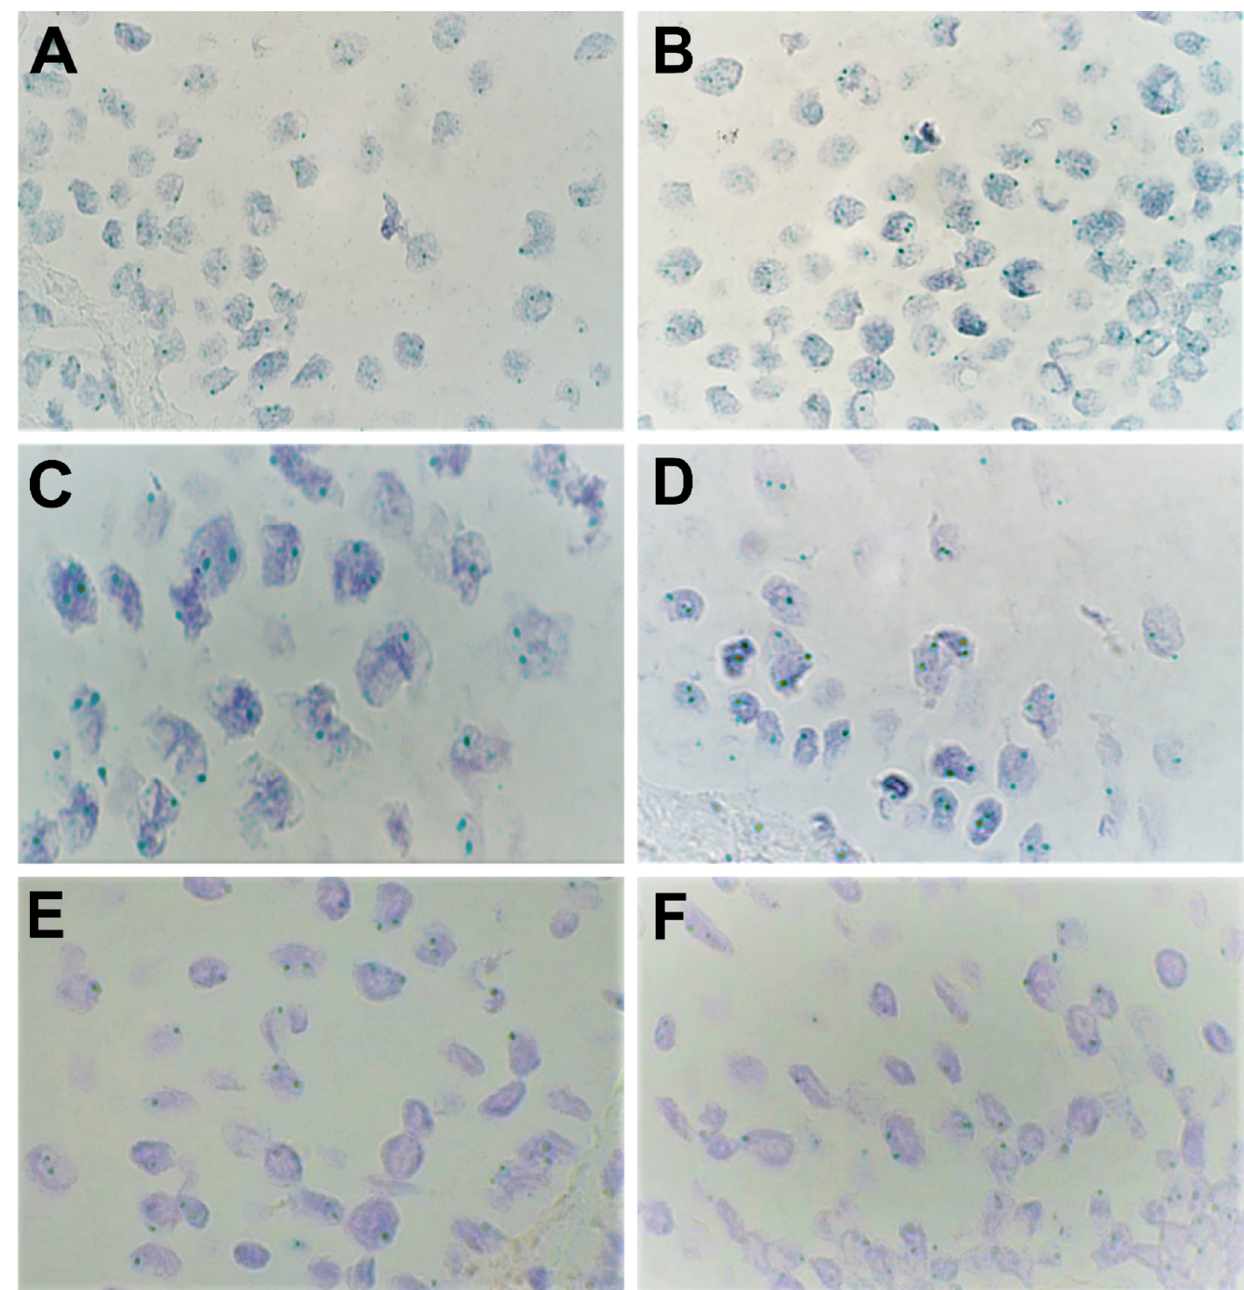
Figure 3. Expression of various genes as shown by chromogenic in-situ hybridization (CISH) in lip mucosal tissue at 1000× magnification (visualized using immersion oil). Amplification was visualized through the number of green signals (dots) per nucleus per cell. ( A , B ) Moderate amplification (++) was found for levels of FGFR1 in the epithelium in patients 2 and 5, respectively. ( C ) Weak amplification (+) and ( D ) no amplification (0) were found for levels of FGFR2 in the epithelium in patients 9 and 1, respectively. ( E , F ) No amplification (0) was found for levels of FOXO1 in the epithelium in patients 8 and 12, respectively.